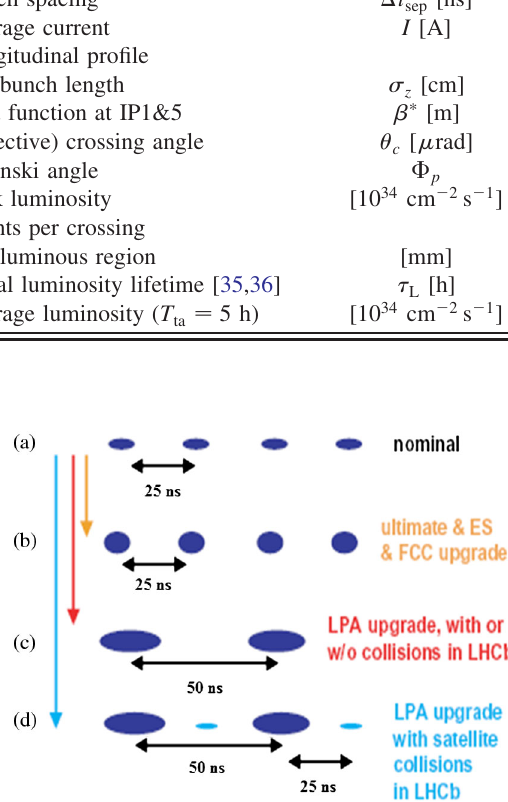
FIG. 8. Bunch patterns for the nominal LHC and various LHC upgrade scenarios.